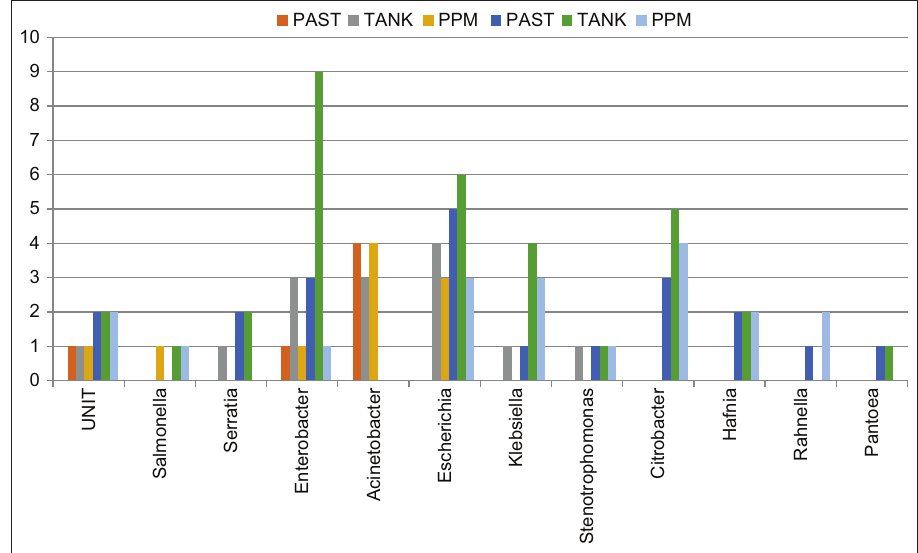
Figure-4: Distribution of Enterobacteriaceae, total coliforms, and thermotolerant coliforms genus during the production process for both units.